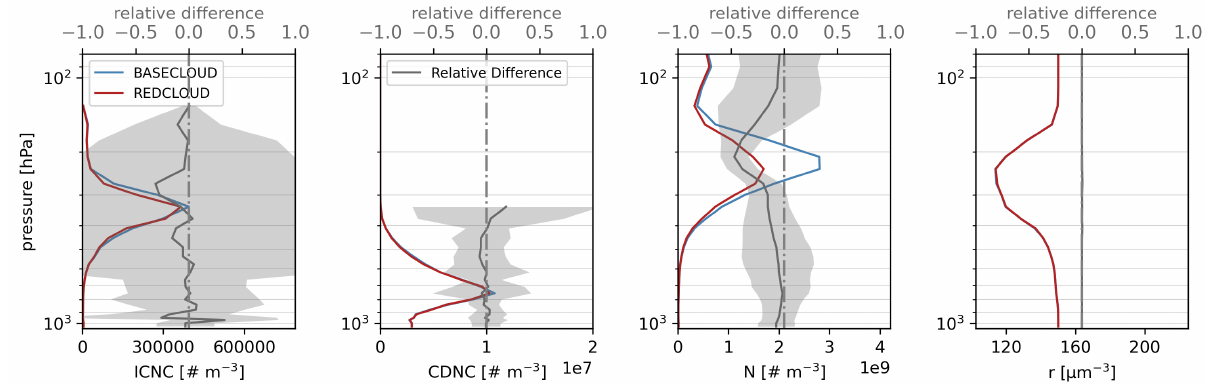
Figure 8. Vertical profiles of the monthly mean ice crystal number concentration (ICNC), cloud droplet number concentration (CDNC), aerosol number concentration ( N ), and ice crystal effective radius ( r ) of the reduced-emission scenario REDCLOUD (red), the standard emission scenario BASECLOUD (blue), and their relative difference (grey line) for May 2020 over Europe. The grey area denotes the spatial and temporal standard deviation of the relative